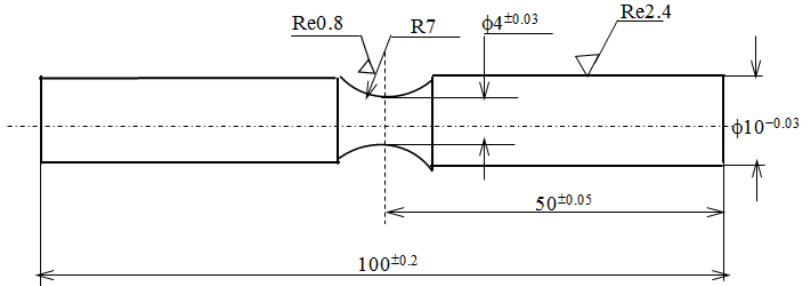
Figure 1. Shape and size sketch of the specimen; all dimensions’ unit: